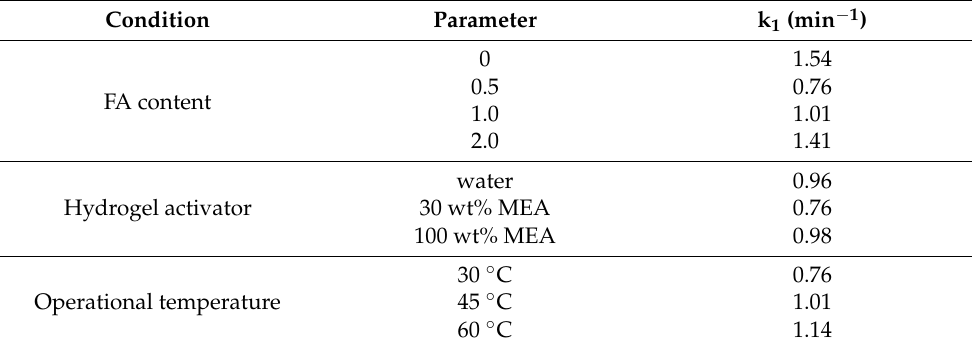
Table 3. Summarize of pseudo-first order rate constant, k 1 at different CO 2 adsorption